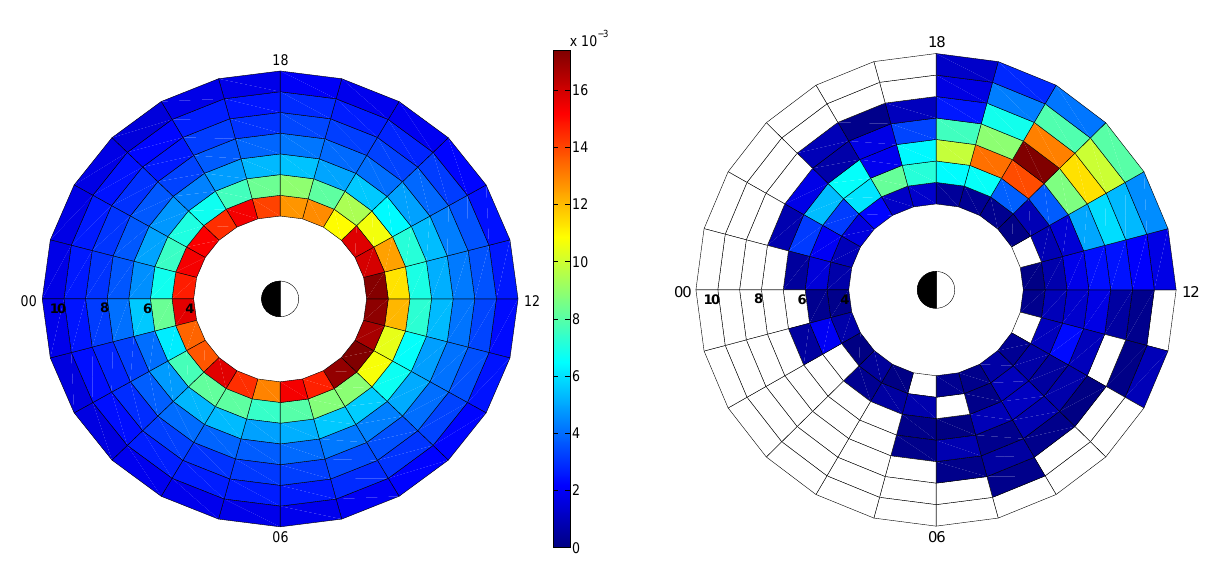
Fig. 8. Probability of being inside a plume structure for each L − MLT bin, normalized by the distribution of all the trajectories. L varies between 4 and 11 R E